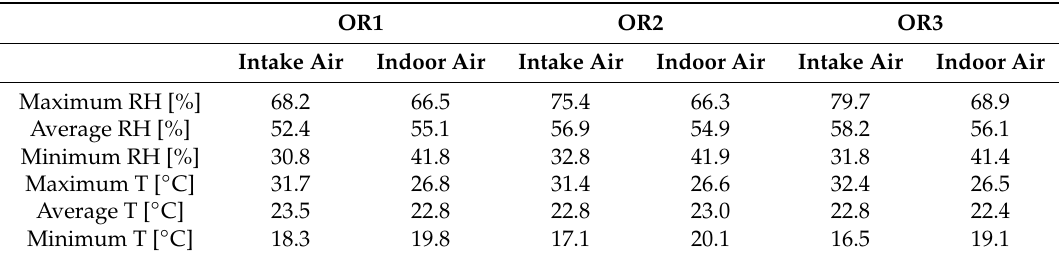
Table 4. Maximum, minimum and average temperature and humidity from the ORs.